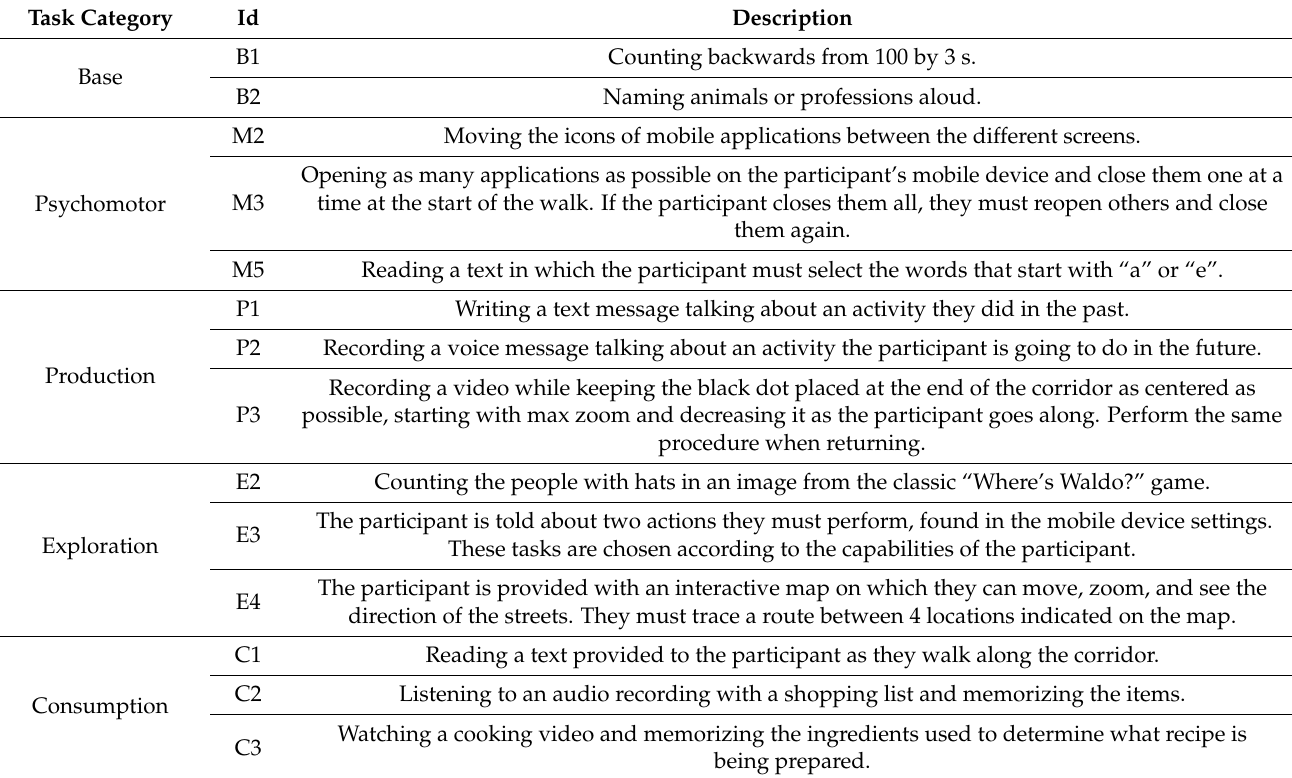
Table 2. List of tasks classification based on AMPEC and according to HuSBIT